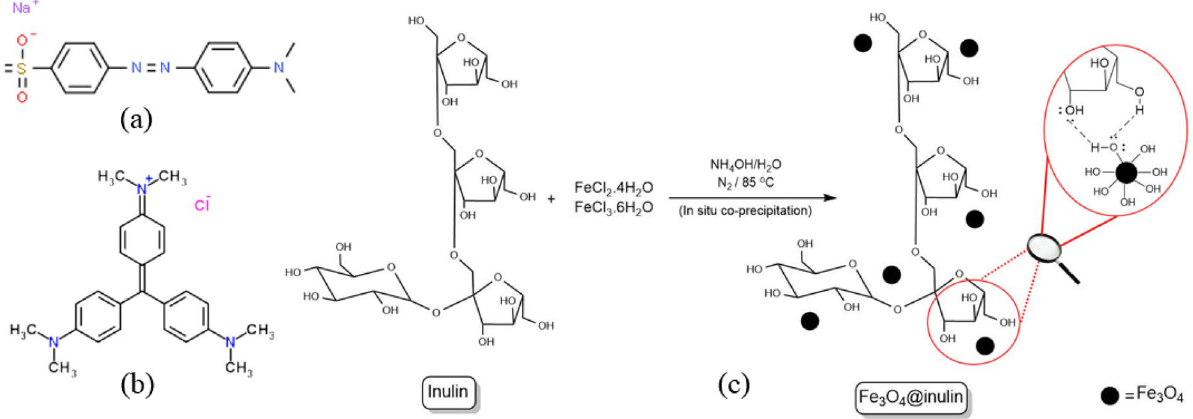
Figure 1. Molecular structures of ( a ) methyl orange, ( b ) crystal violet, and ( c ) Fe 3 O 4 @inulin with synthesis